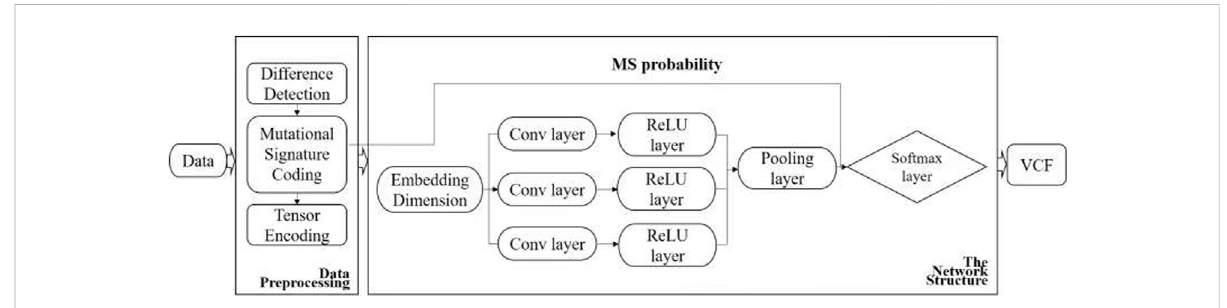
FIGURE 1 Work fl ow of DETexT. The work fl ow of DETexT can be divided into two parts: data pre-processing and network structure. 1) Data pre- processing includes different base detection, mutational signature encoding, and tensor encoding. 2) The network structure consists of three convolution fi lters, each followedby a ReLU layer. The mutational signature probabilities are applied before the Softmax layer. The output is the true SNV after the false positive fi